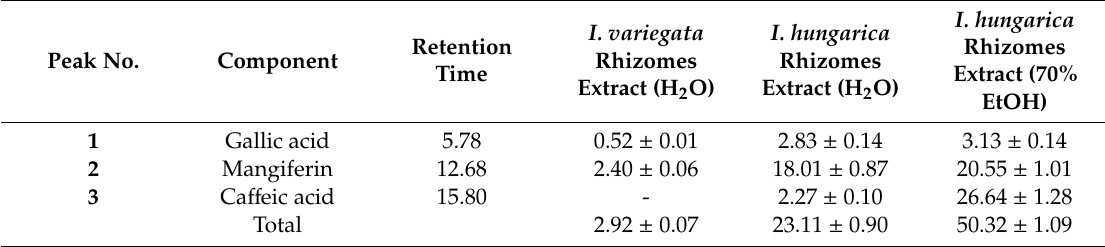
Table 5. The radical scavenging activity of individual compounds of I. variegata and I. hungarica extracts expressed as TEAC ( µ mol / g) using the ABTS post-column